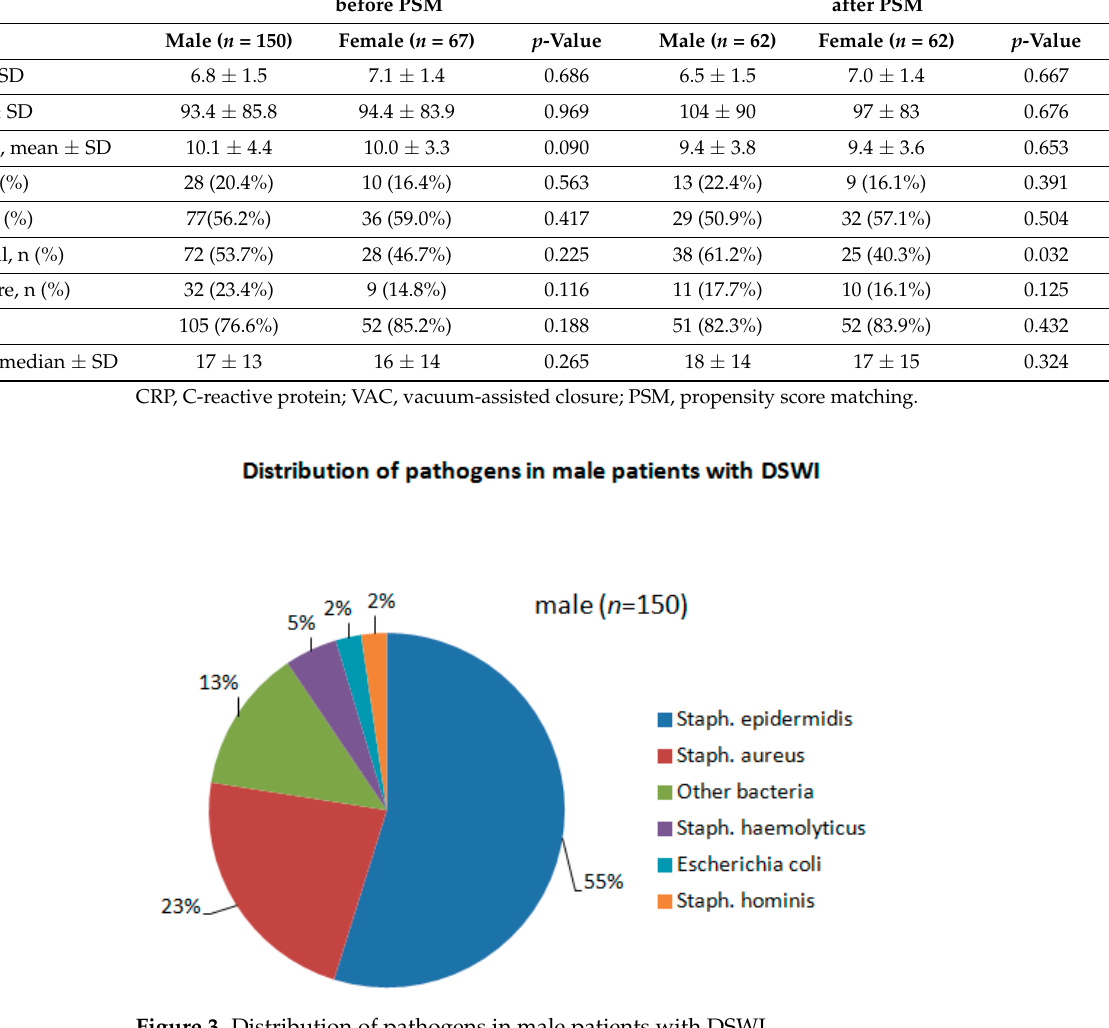
Figure 3. Distribution of pathogens in male patients with